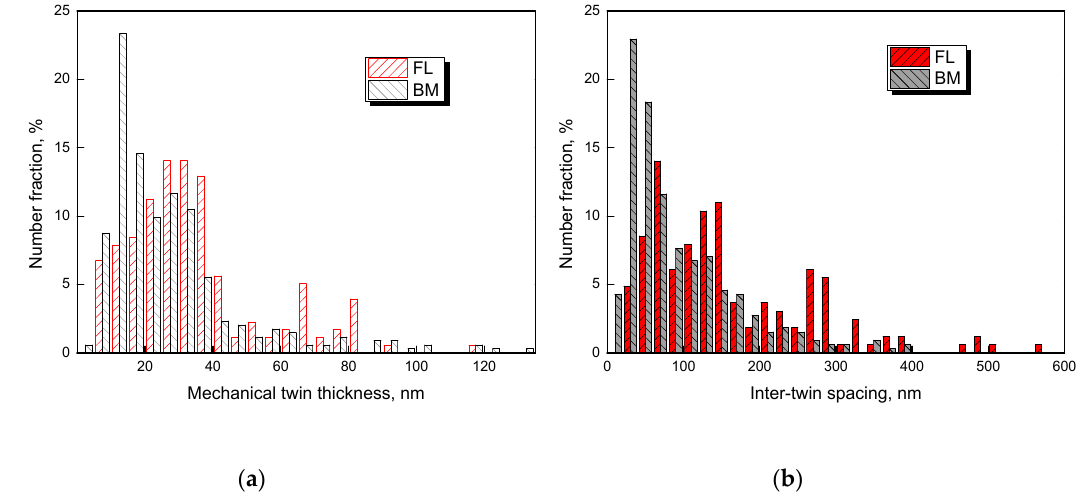
Figure 7. Distribution map of ( a ) mechanical twin thickness and ( b ) inter-twin spacing in deformed microstructures close to fracture surface of impact samples.